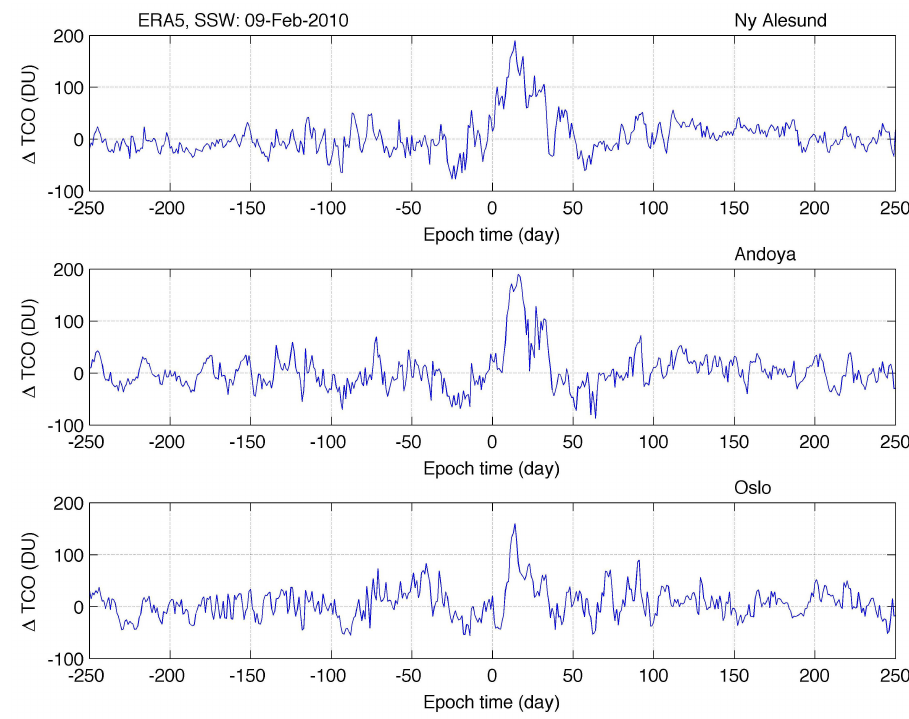
Figure 2. ERA5 estimate of the anomalies in TCO with respect to the climatology at Ny Ålesund, Andøya and Oslo. Epoch time 0 corresponds to the central date of 9 February 2010 of the major SSW.